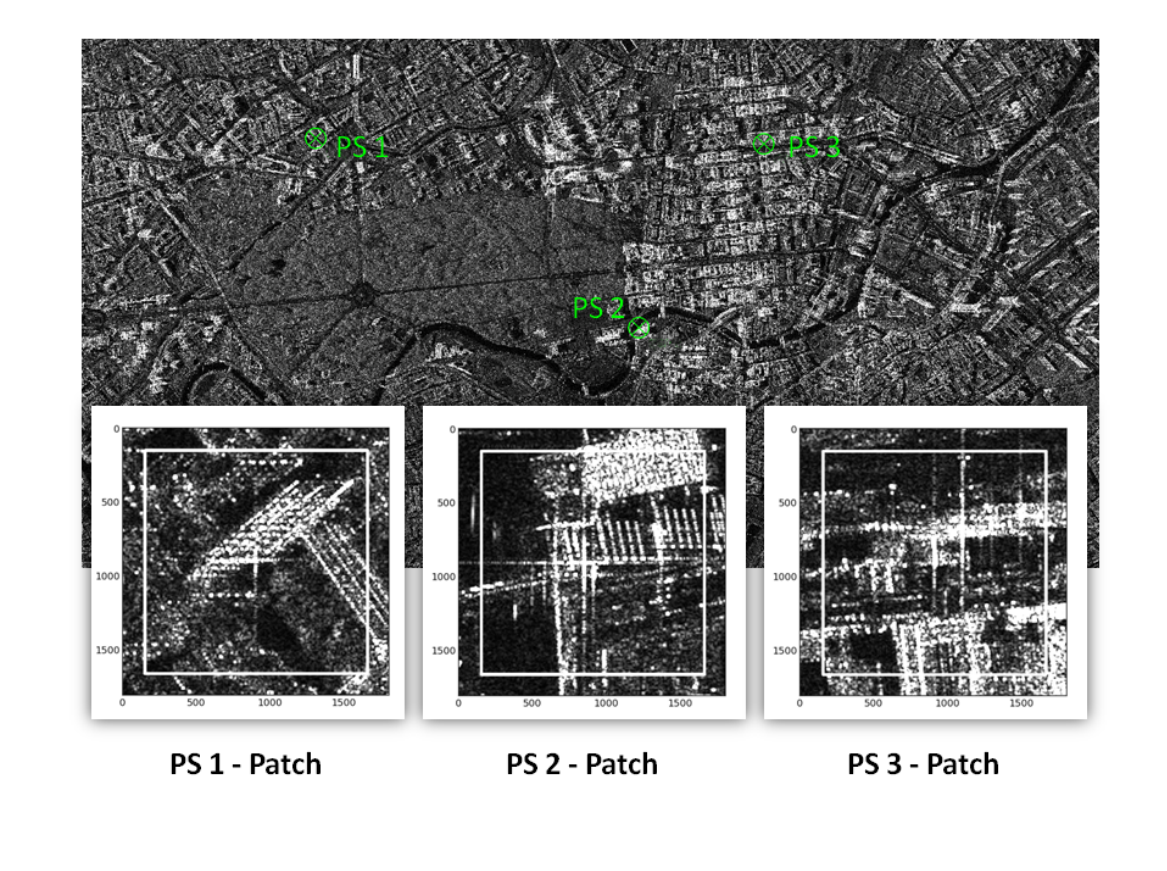
Figure 3: TSX Image of Berlin and the PS’s position and patches